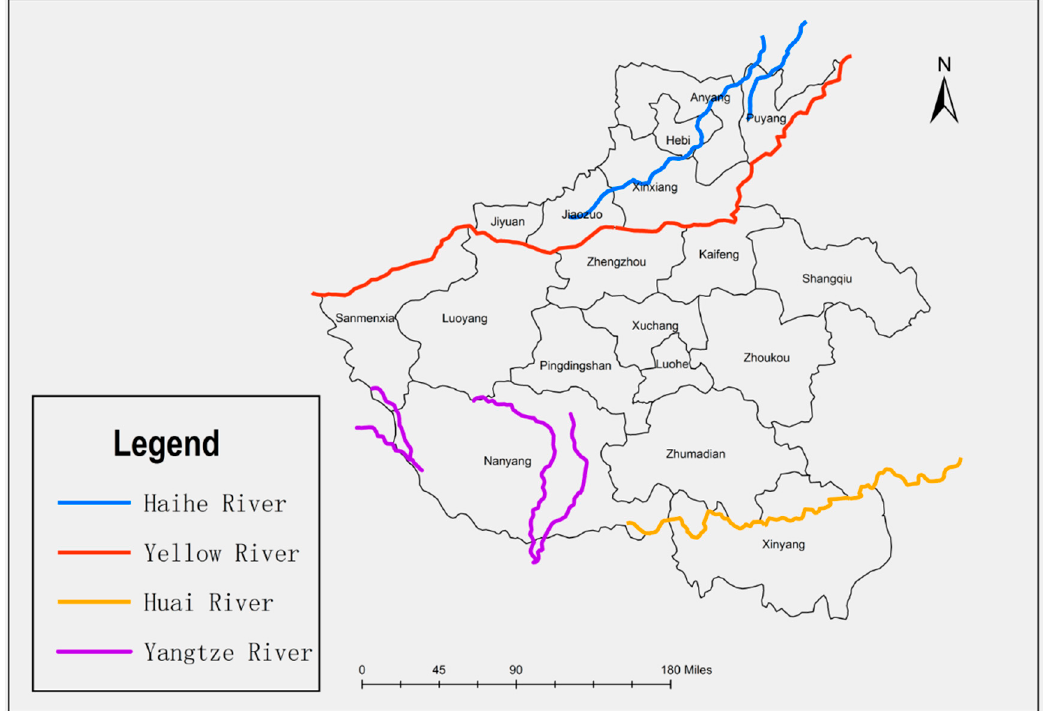
Figure 1. Four major river basins in Henan Province, China.